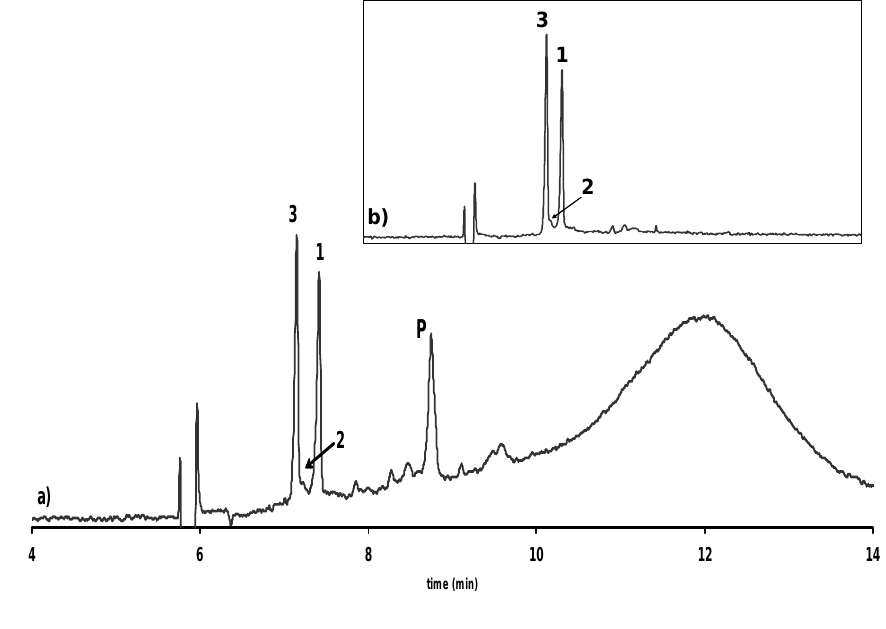
Figure 5. Electropherogram showing the enantioselective separation of catechin and epicatechin in a) an extract of cocoa powder and b) isolated from this